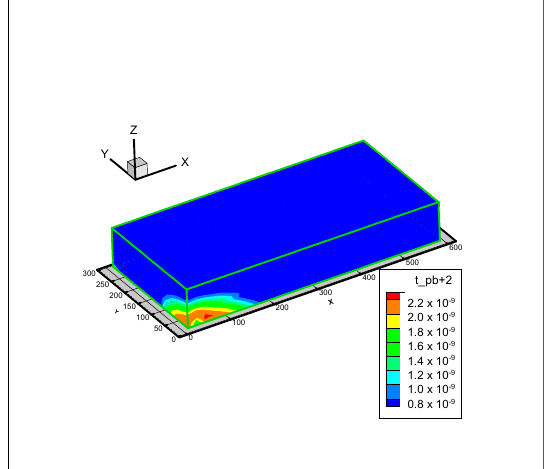
Figure 18. Contour map of total lead (Pb) concentration after 100 years of CO 2 leakage.